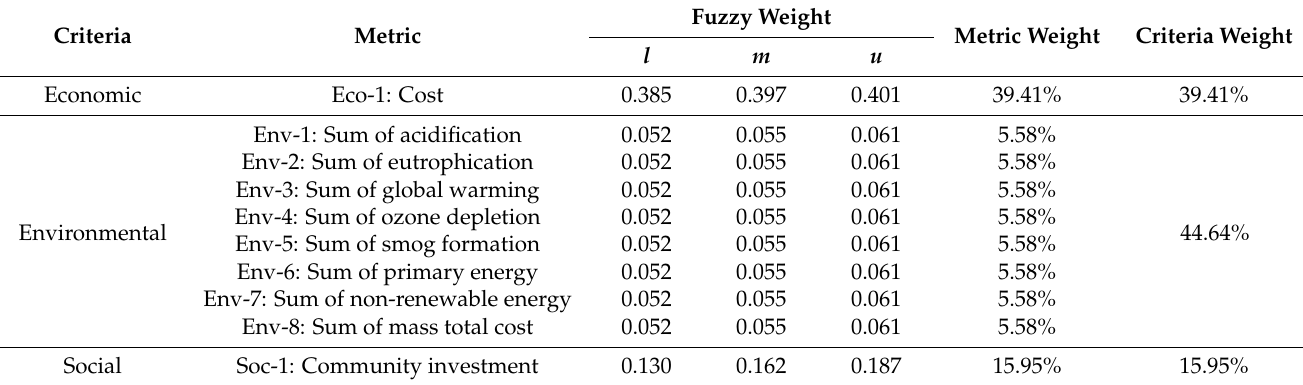
Table 10. Matrix of fuzzy